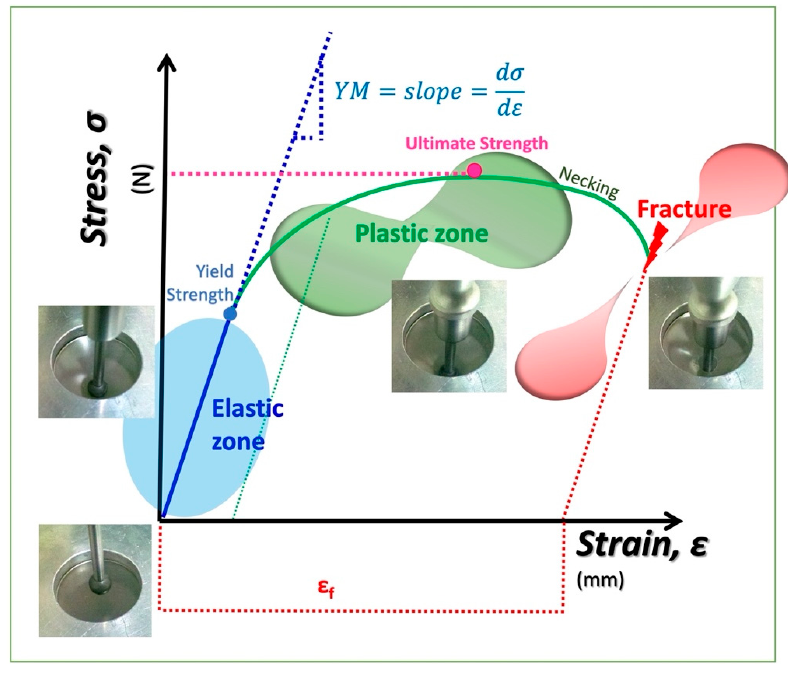
Figure 5 . Force–deformation curve [74] .